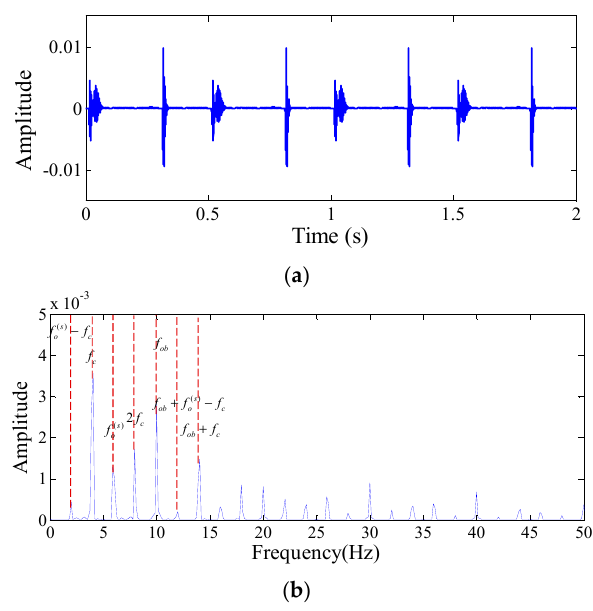
Figure 8. The analytic results of planet gear bearing outer ring fault simulation signal. ( a ) Time domain waveform of simulation signal; ( b ) The envelope spectrum of simulation signal.